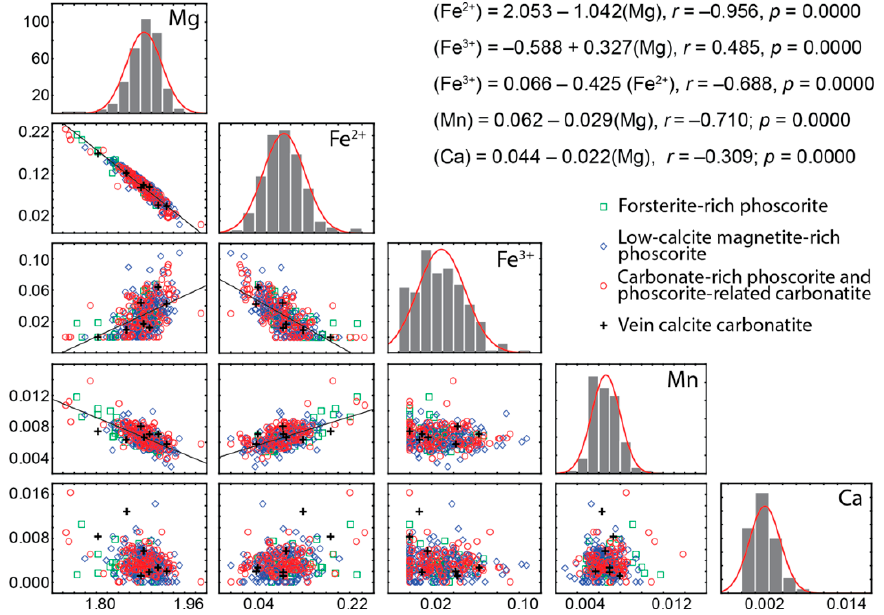
Figure 7. Matrix diagram for major octahedral cations of forsterite ( apfu ). Table 4. Results of factor analysis of forsterite composition .